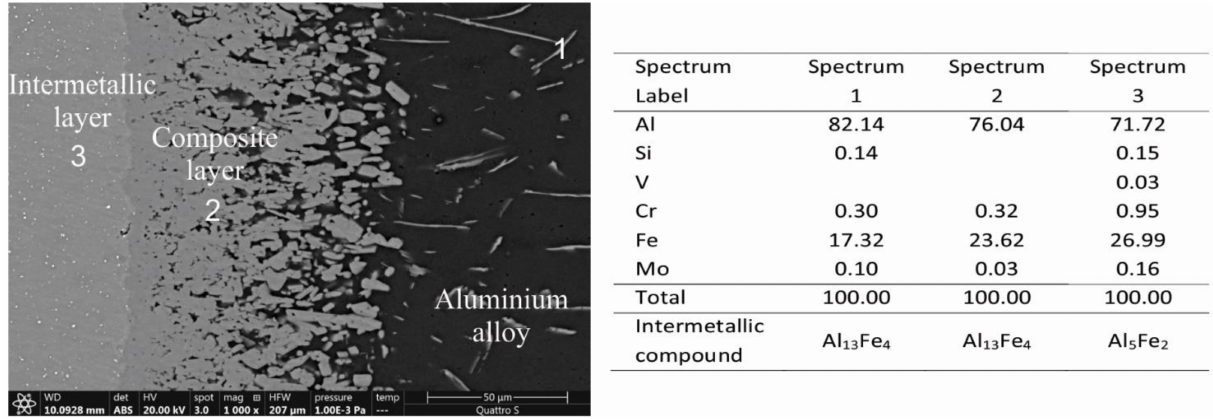
Figure 6. SEM micrographs of the interaction layer of the UTOPMO1 sample tested at 700 ◦ C in Al99.7 aluminum alloy. The corresponding EDS results are presented in at %.